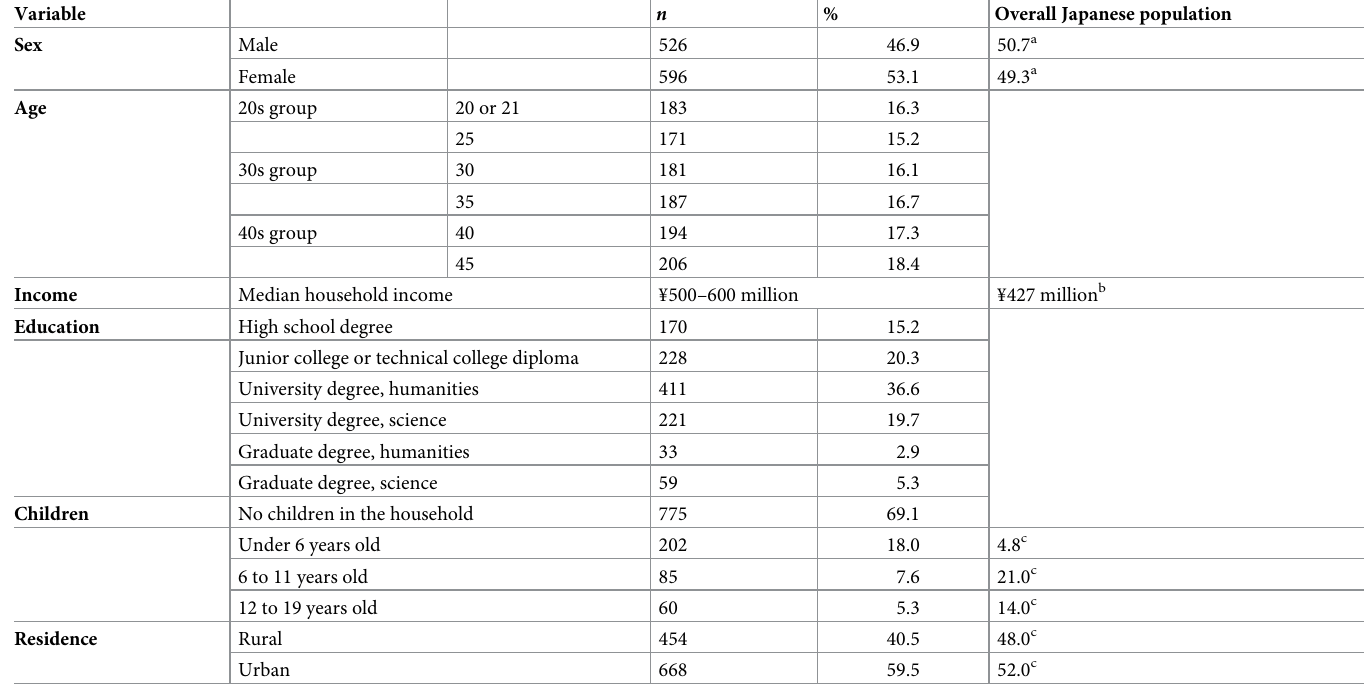
Table 1. Participants’ sociodemographic characteristics ( n =